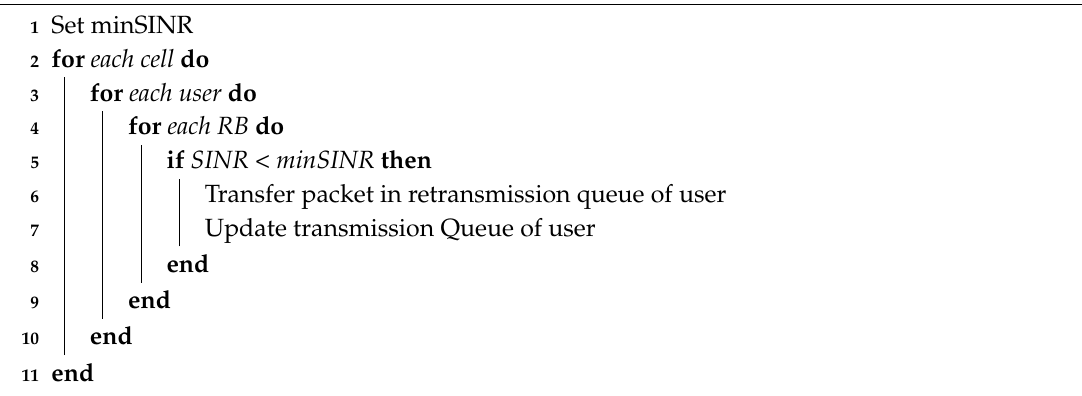
Algorithm 7: Packet to retransmit identification